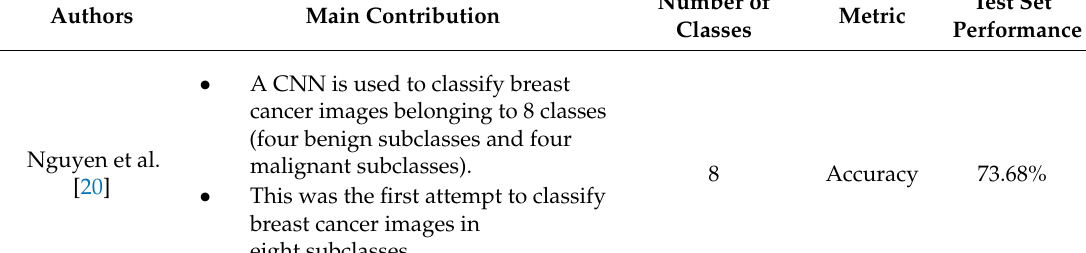
Table 1. Recent studies in the area of histopathological image